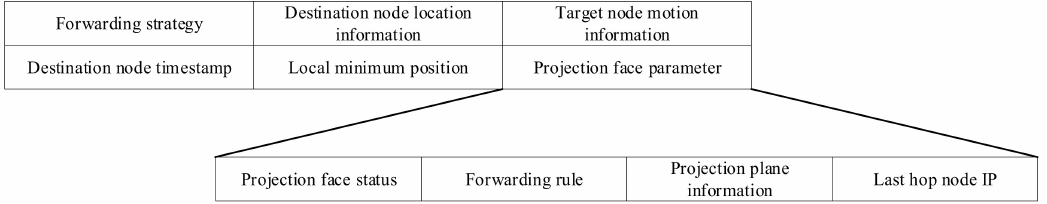
Figure 4. RGF data packet header format.